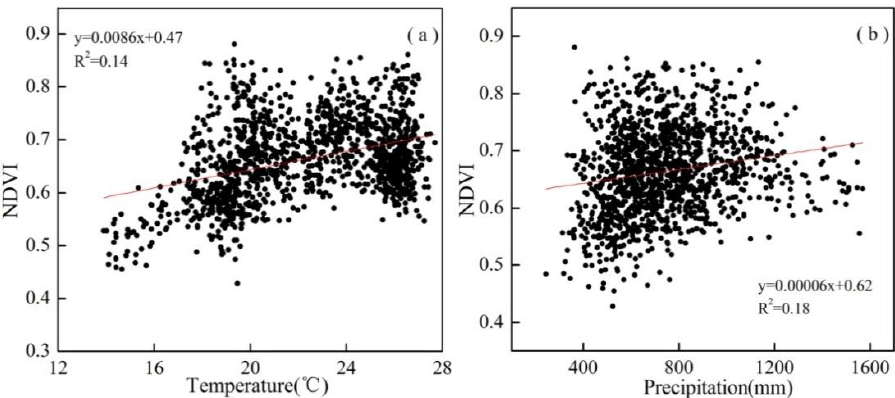
Figure 6. The overall relationship between annual growing-season NDVI and temperature ( a ); precipitation ( b ) during 1982–2013. These three sets of data are the annual average for growing-season NDVI, temperature and accumulated precipitation of 32 years for 43